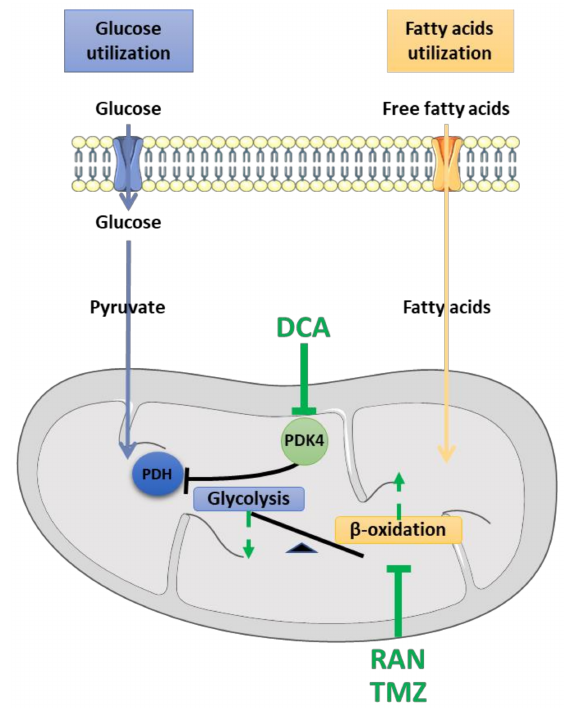
Figure 3. Metabolic reprogramming of skeletal muscle by pharmacological